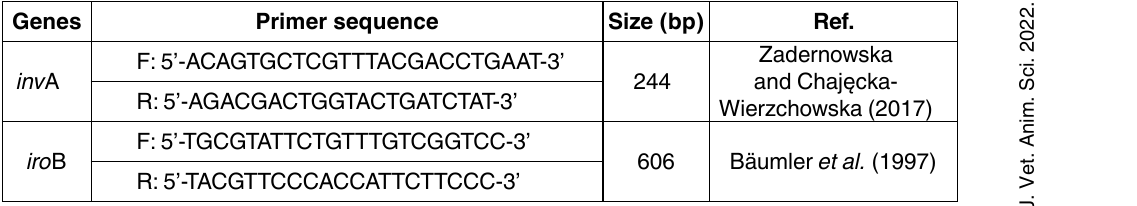
table 1 . Primers used for identification of inv A and iro B genes Genes